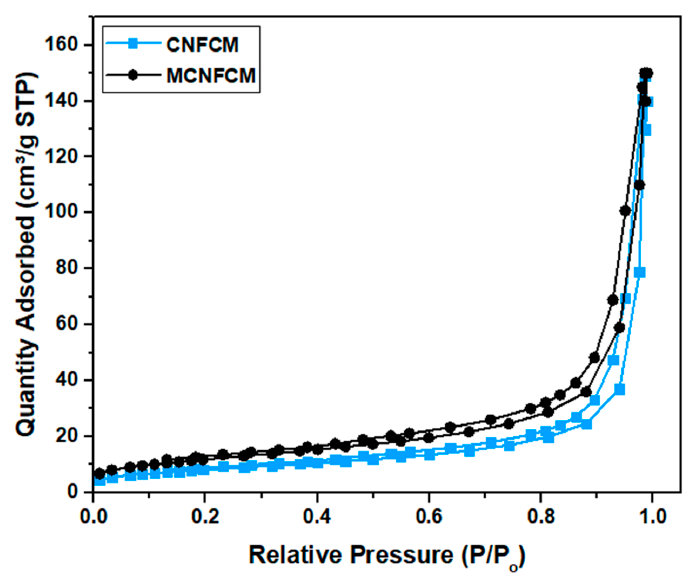
Figure 9. N 2 ads–des isotherm of CNFCM and modified CNFCM.